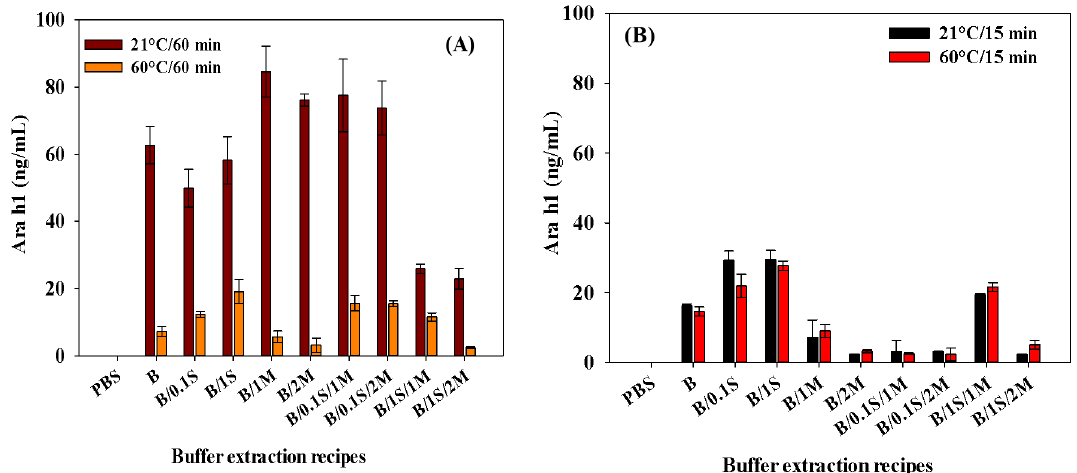
Figure 4. Effect of extraction time and temperature: ( A ) 21 °C for 60 min, 60 °C for 60 min; ( B ) 21 °C for 15 min, 60 °C/15 min for Ara h1 recovery from peanut butter food extract. B denotes only Tris-HNO 3 buffer (pH 8.4); 0.1 S denotes 0.1 M NaCl; 1 S denotes 1 M NaCl; 1 M denotes 1 g of skim milk powder; 2 M denotes 2 g of skim milk powder.